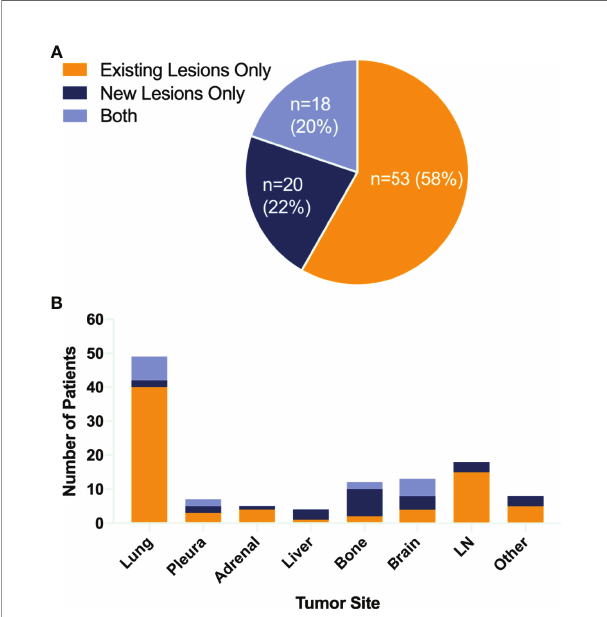
FIGURE 3 | Patterns of failure. Pie chart (A) showing the proportion of different failure lesions. Bar graph (B) showing both sites of tumor growth and the number of patients. LN, lymph node.